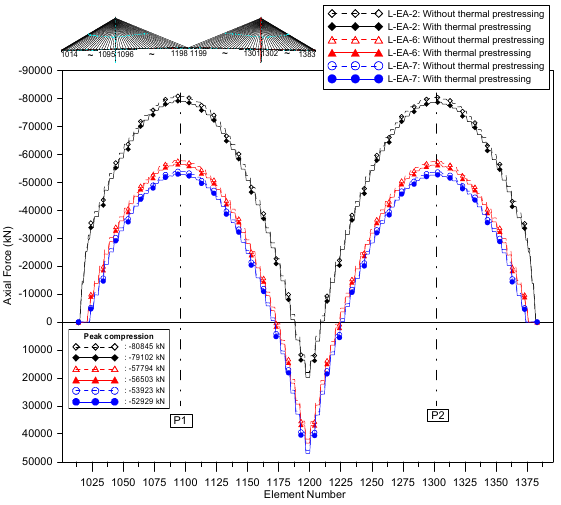
Figure 18. Axial girder forces with various numbers of earth-anchored cables.